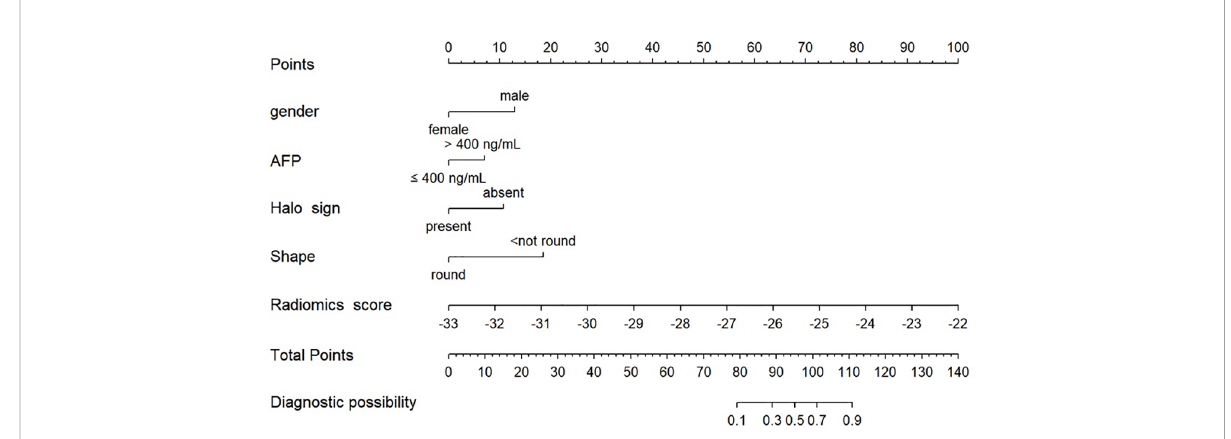
FIGURE 3 Radiomics nomogram combining the radiomics signature derived from HBP 15min MR images and clinicoradiological factors including gender, AFP, halo sign and shape for predicting MVI in the training cohort.